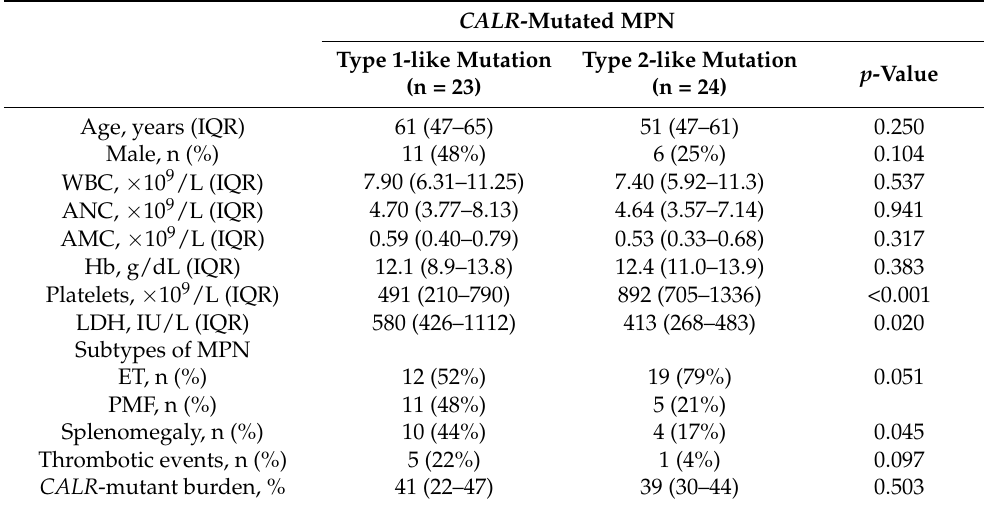
Table 3. Comparison of patients’ clinical and laboratory characteristics according to the CALR mutant types. CALR -Mutated